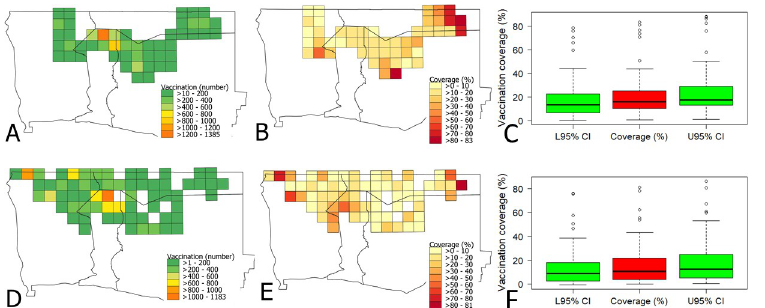
Fig 2. Maps and box plots showing vaccination and vaccination coverage. Grid cells (20 x 20 km) based map of the study area showing the number of dog vaccinated ( A ), vaccination coverage achieved per grid cell ( B ) and boxplot of the overall vaccination coverage and 95% confidence interval during the 2019 MDV campaign ( C ). The 2020 vaccination campaign data is represented by the number of dogs vaccinated ( D ), vaccination coverage achieved per grid cell ( E ), and boxplot of the average vaccination coverage and 95% confidence interval ( F ).